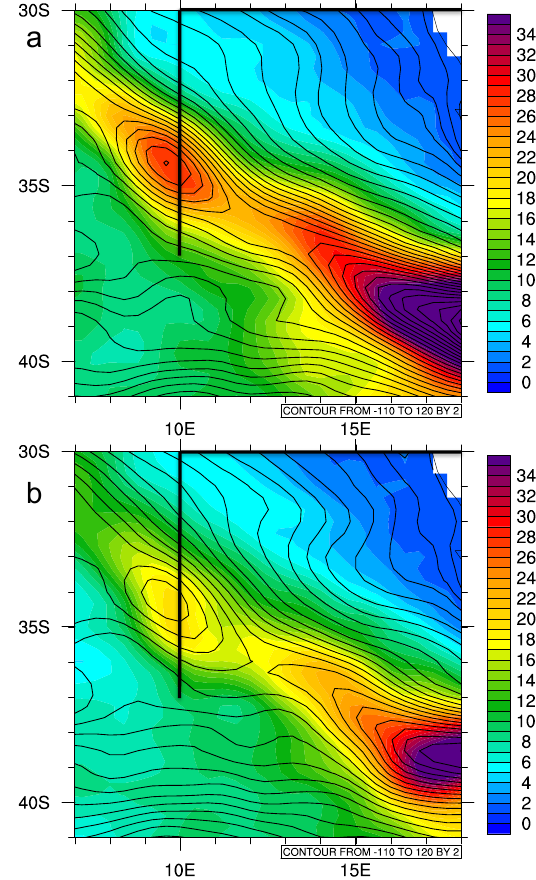
Fig. 7. Contour of mean dynamic topography and standard devi- ation (colors, in cm) from (a) POP CTRL and (b) POP ITF. This zoom on the Agulhas eddy corridor shows the increase variability due to an opening of the Indonesian Passage. The black line shows the section used to compute the Agulhas leakage.